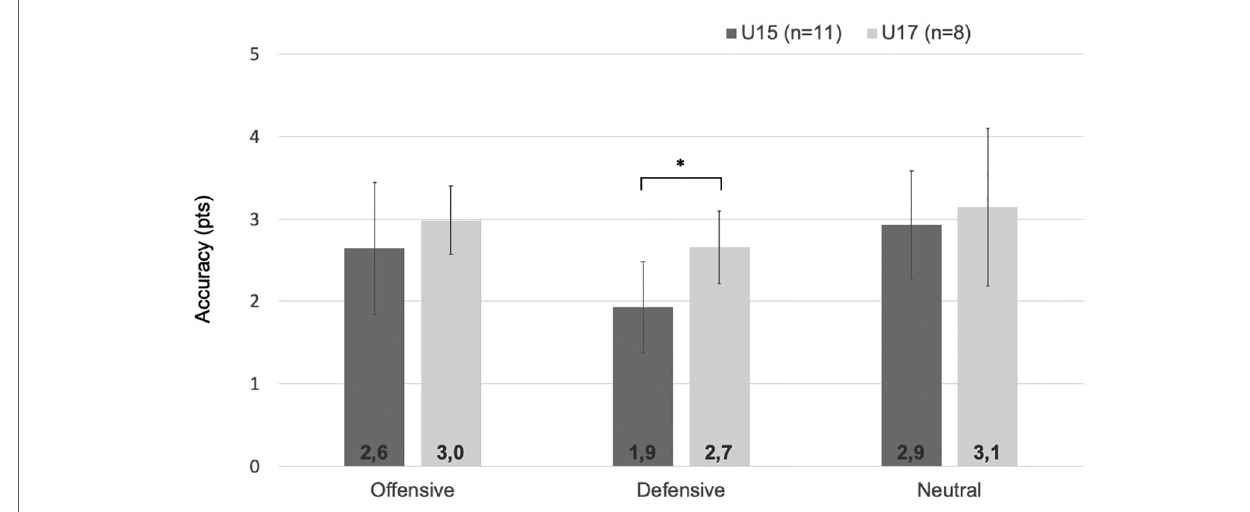
FIGURE 3 Accuracy in tactical situations for players U15 and U17. This fi gure shows the mean accuracy in tactical situations (errors bars represent standard deviations of the mean); * p <0.05 signi fi cant difference between players U15 and U17 for